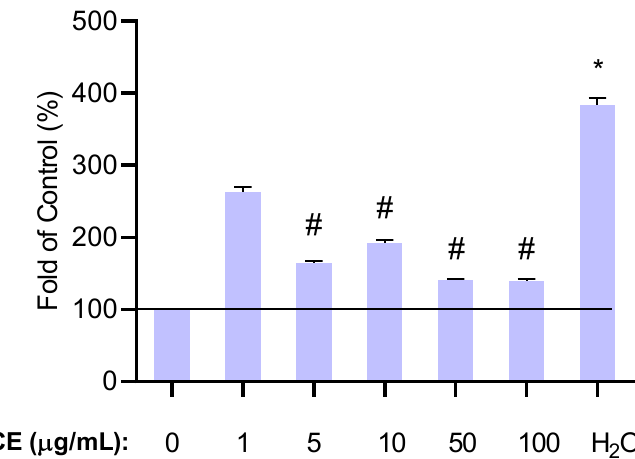
Figure 5. Effect of ACE on the level of reactive oxygen species (ROS) in various concentrations. * indicates the significant increase of ROS after H 2 O 2 treatment compared to the control. # indicates the significant changes in ROS after H 2 O 2 and ACE treatment compared to the H 2 O 2 treatment without ACE. Results are expressed in the percentage of the control (100% is represented by the solid lines). Data are expressed as the mean ± SEM of four individual experiments. H 2 O 2 , hydrogen peroxide (positive control for oxidative stress); ACE, anthocyanin extract.